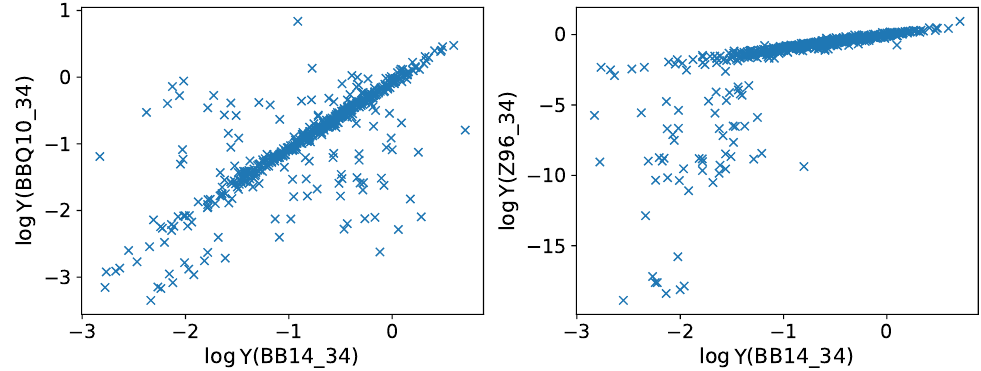
Figure 6. Comparison of [Fe III ] ECS at T = 10 4 K in the coll_BBQ10_34 and coll_Z96_34 datasets with respect to those in